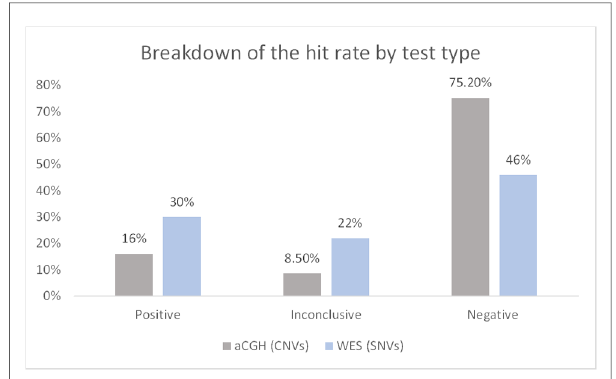
FIGURE 3 Breakdown of the hit rate by test type. The number of solved cases (CNVs/SNVs) was divided by the total number of cases. Data represented as percentage. CNVs, copy number variations; SNVs, single-nucleotide